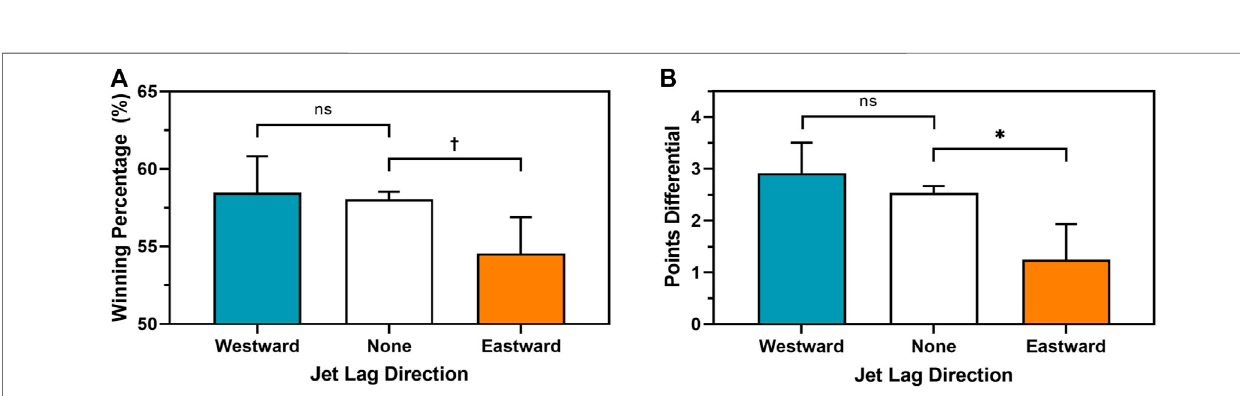
FIGURE 2 | Raw means based on the association between directional jet lag (blue = westward, white = none (reference), orange = eastward), and home team (A) winning percentage; and (B) points differential. ns = not signi fi cant, p > 0.10, † p < 0.07, * p <